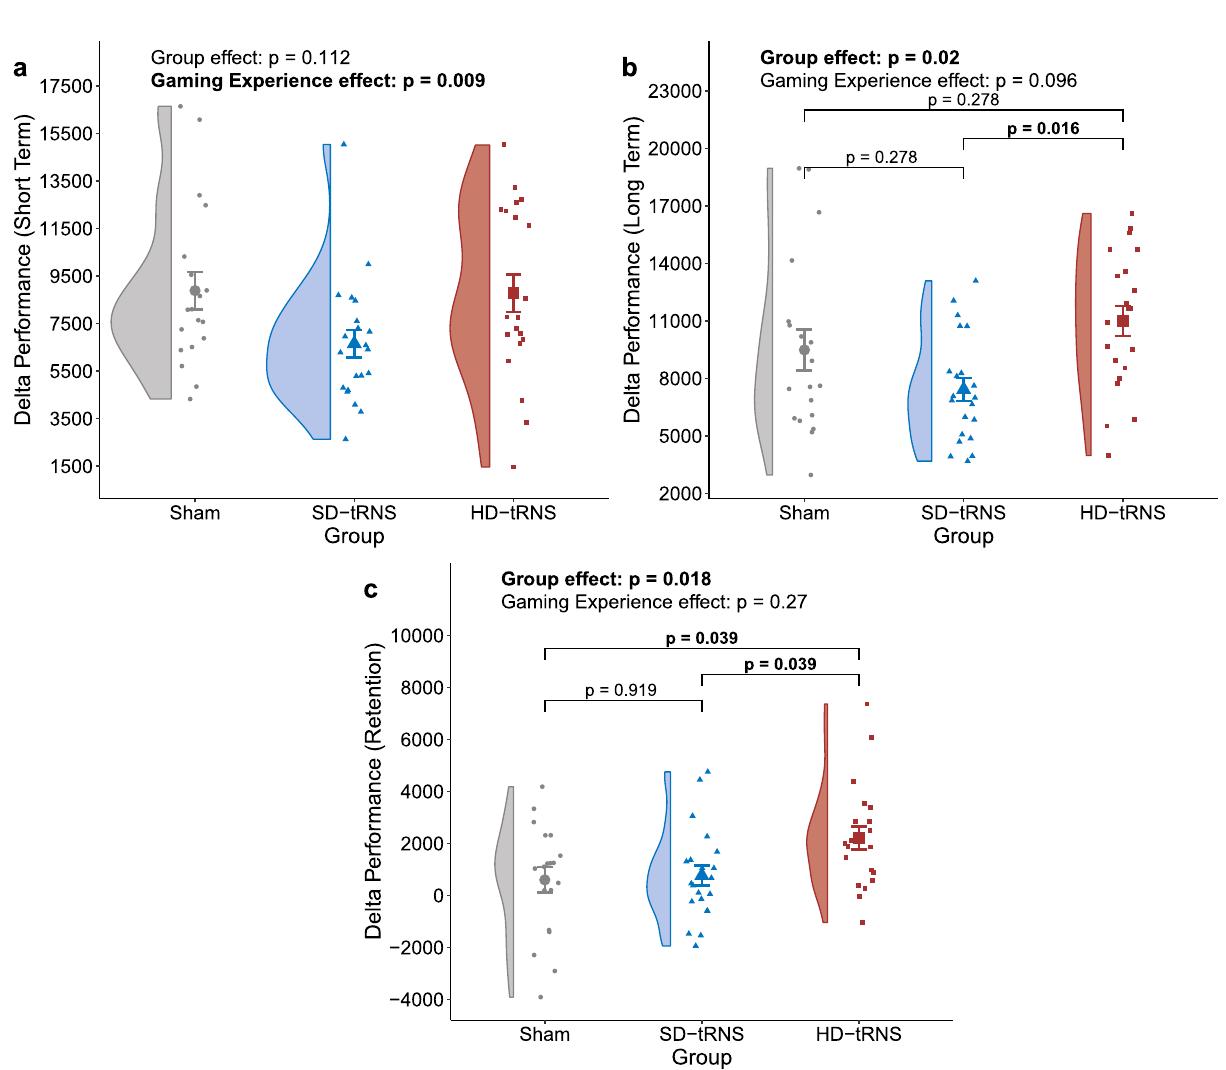
Figure 4. ( a ) Delta between short-term and baseline performance (Hypothesis 2.a.). ( b ) Delta between long- term and baseline performance (Hypothesis 2.b.). ( c ) Delta between long-term and short-term performance (Hypothesis 3.). GS Game Session. Bold: p < 0.05